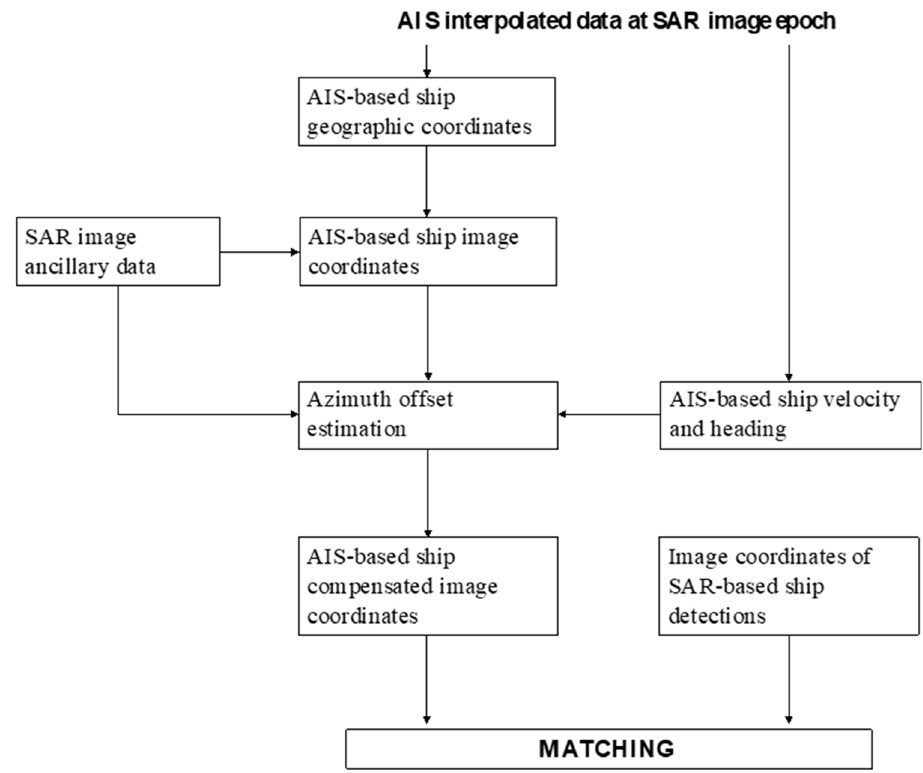
Figure 2. Flow-chart of conventional automatic identification system (AIS)-synthetic aperture radar (SAR) matching approach exploiting AIS-based ship route information [17].